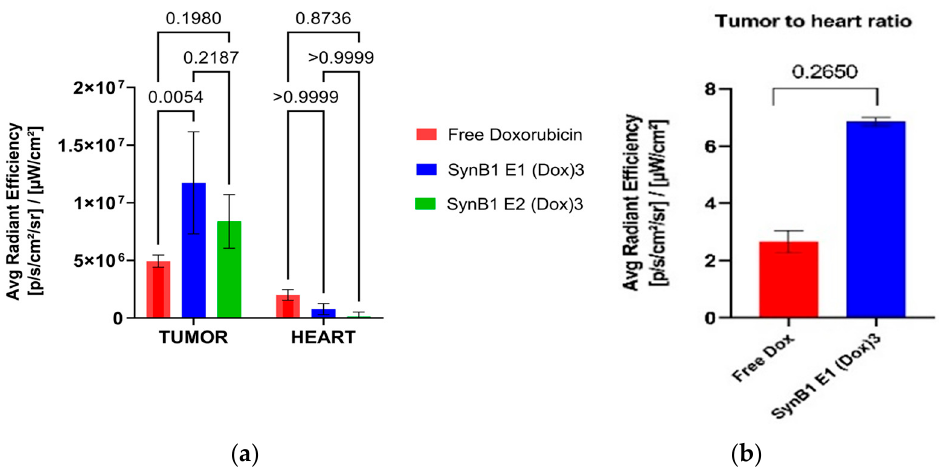
Figure 4. Dox accumulation in heart and tumor. Tumor-bearing nude mice were treated with either 10 mg Dox equivalent/kg free dox or biopolymer-dox in the absence or presence of hyperthermia. ( a ) Dox fluorescence intensity in tumor and heart samples of treated animals. ( b ) Ratio of tumor to heart dox concentration at 6 h post-injection. p < 0.01 (ANOVA, Bonferroni contrast, mean ± s.d; n = 5).